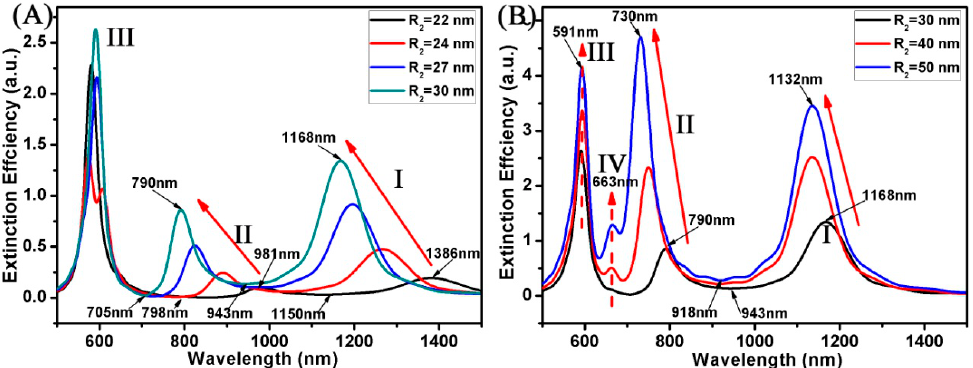
Figure 4. ( A , B ) Spectra calculated for the Au ring-disk nanostructures with different R 2 . The R 1 of the ring was unchanged (R 1 = 20 nm). The R 3 of the disk was unchanged (R 3 = 30 nm). The H of the ring-disk nanostructures was unchanged (H 1 = H 2 = H = 10 nm). The R 2 of the ring increased from 22 to 50